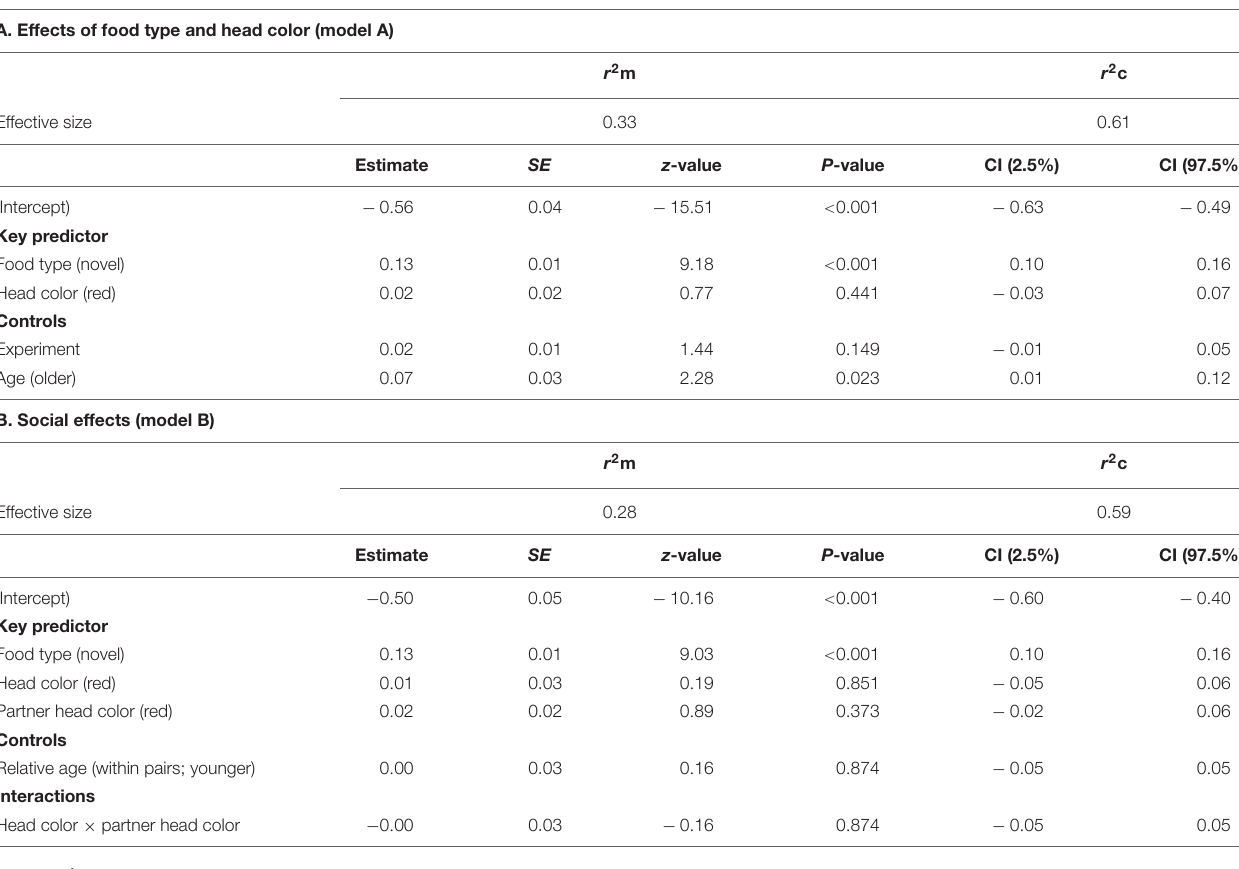
TABLE 3 | Results of the linear mixed effects models on the latencies to first feed on familiar and novel food of Gouldian finches addressing (A) the relationship between food type and color morph (model A) and (B) social effects (model B). Only the final model for each analysis is shown. The reference modality is in parentheses.